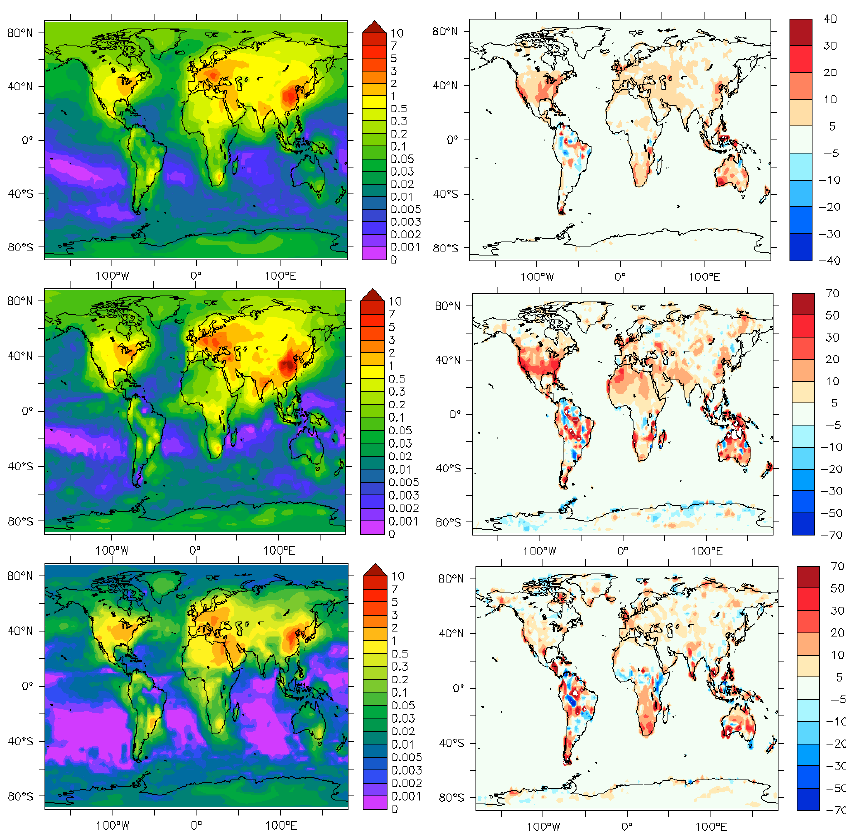
Fig. 8. Simulated aerosol ammonium concentration (µgm − 3 ) near the surface for the mean annual (upper panels), boreal winter (January, middle panels) and summer (July, lower panels) conditions and relative changes (in %, right panels) due to HONO enhancement in the